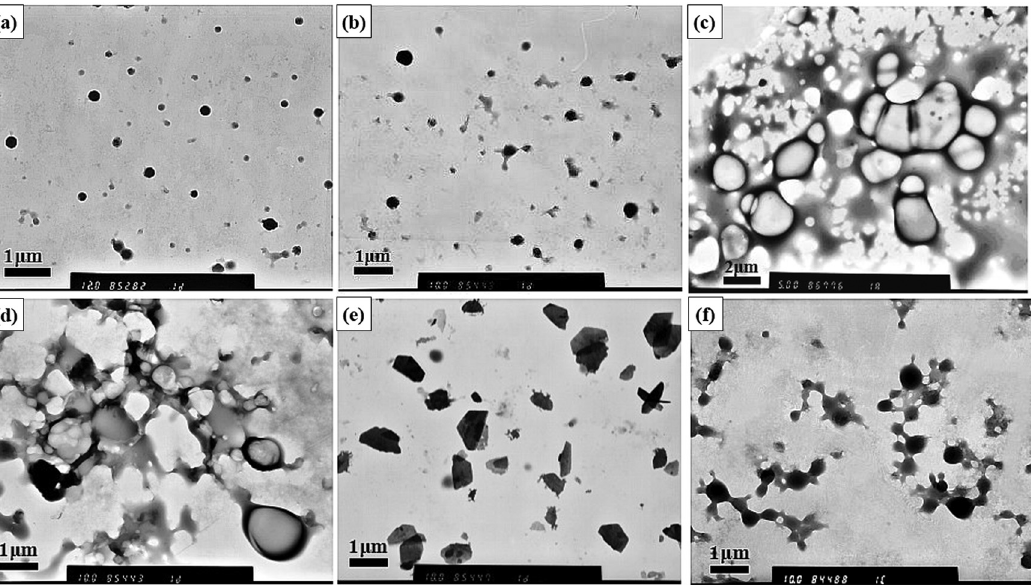
Figure 6: TEM images of aggregates formed from DSPE – PEG5k/PDLLA – MPEG mixtures with the mass ratio of DSPE – PEG5k to MPEG – PDLLA: ( a ) 0:1, ( b ) 0.0001:1, ( c ) 0.0005:1, ( d ) 0.001:1, ( e ) 0.005:1 and ( f )